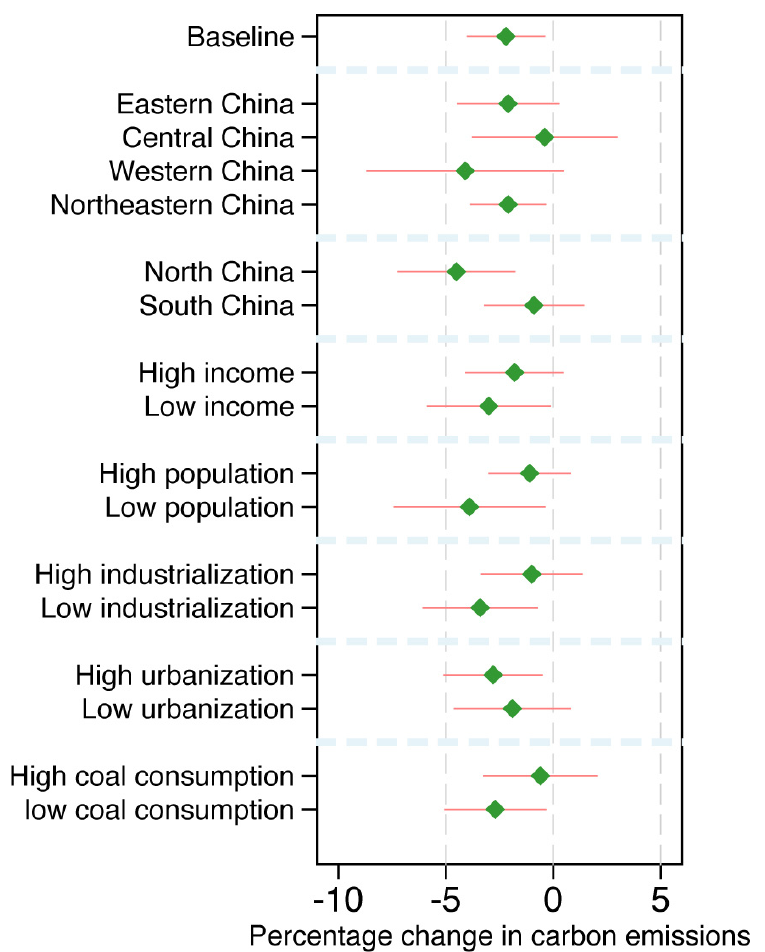
Figure 2. Heterogeneity analysis. The green diamond points represent the estimates, while the red lines represent their 95% confidence intervals.